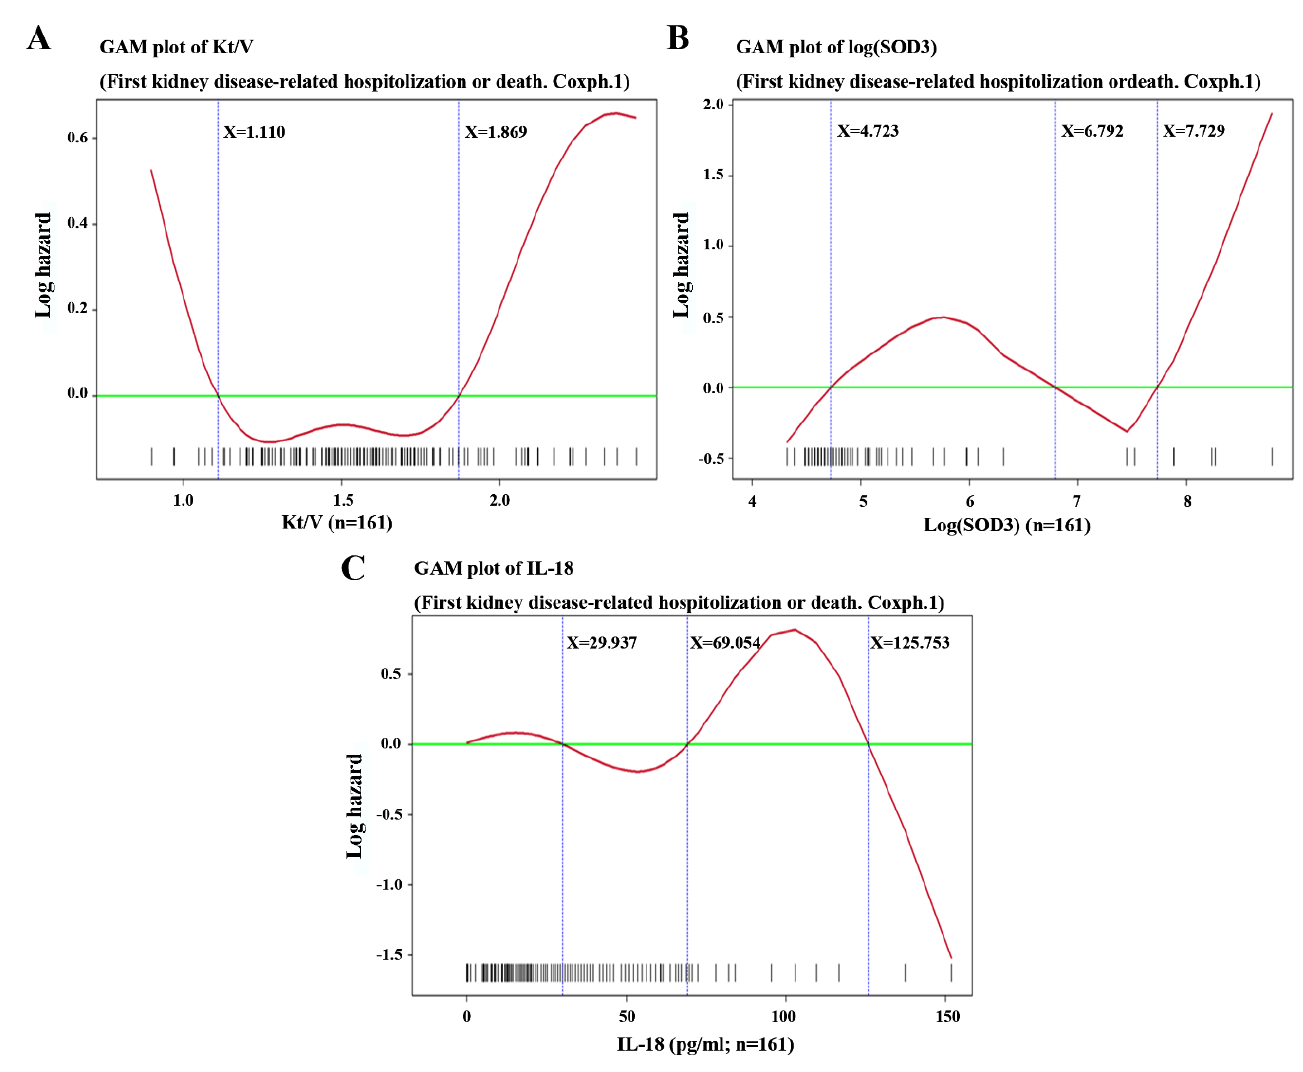
Figure 7. Generalized additive model (GAM) plots of the first kidney disease-related hospitalization or death versus ( A ) Kt/V, where Kt/V below 1.088 or over 1.992 brought a high risk; ( B ) log(SOD3), where log(SOD3) > 4.723 brought a high risk of events. Plasma SOD3 and Kt/V urea are closely related in the clinic. Given a log(SOD3) < 4.723 and Kt/V > 1.11 or <1.869, the patient has a lower risk of kidney disease-related hospitalization or death; and ( C ) IL-18 (pg/mL) (1.2166 ± 0.5010, p = 0.0152), where IL-18 over 69.054 conferred a high risk of